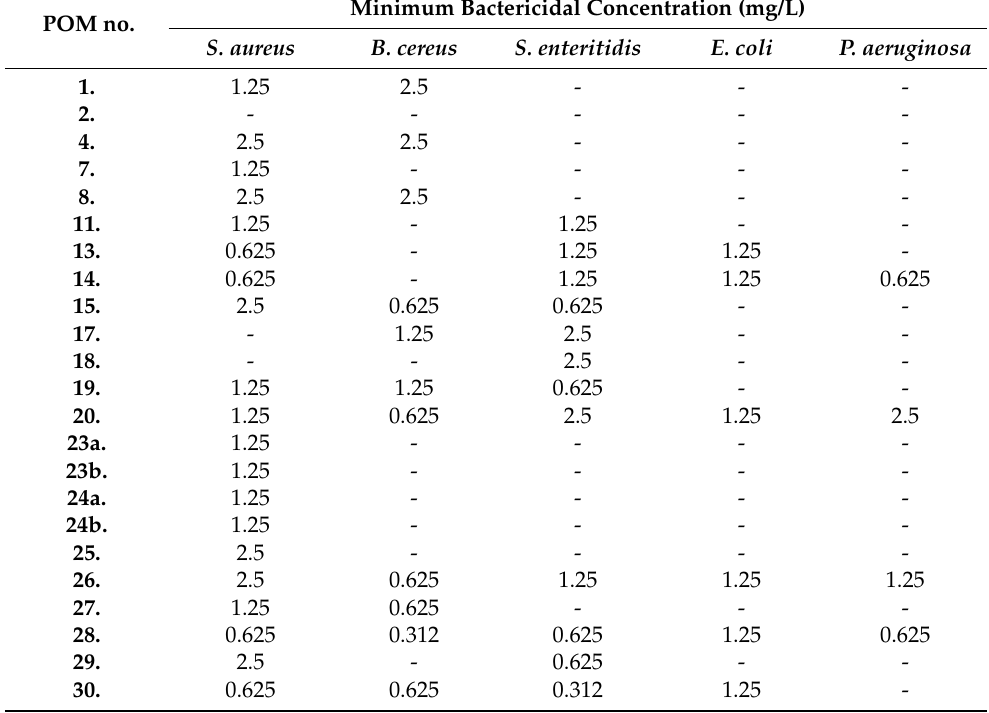
Table 5. Minimum bactericidal concentration of active